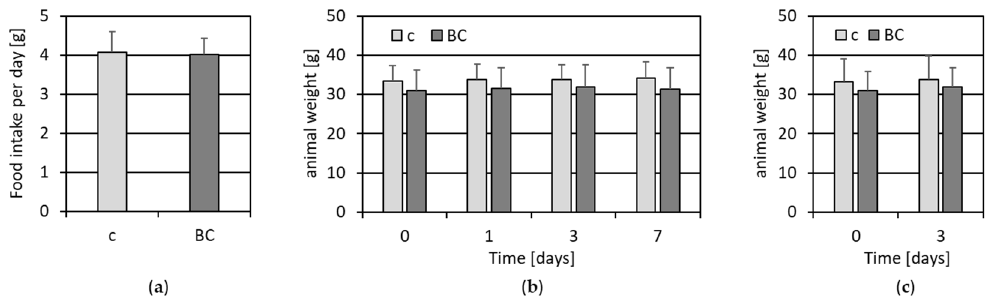
Figure 1. Food intake and animal weight. ( a ) The mean food intake of all animals per day in [g] with standard deviation is shown. Animals received either control food (c) or food supplemented with 15 % bread crust (BC). ( b ) The mean value of animal weight with standard deviation before (0) and upon 1, 3 and 7 days’ feed ( n = 18; c = 7; BC = 11). ( c ) The mean value of animal weight with standard deviation before (0) and upon 3 days’ feed ( n = 31; c = 13; BC = 18).